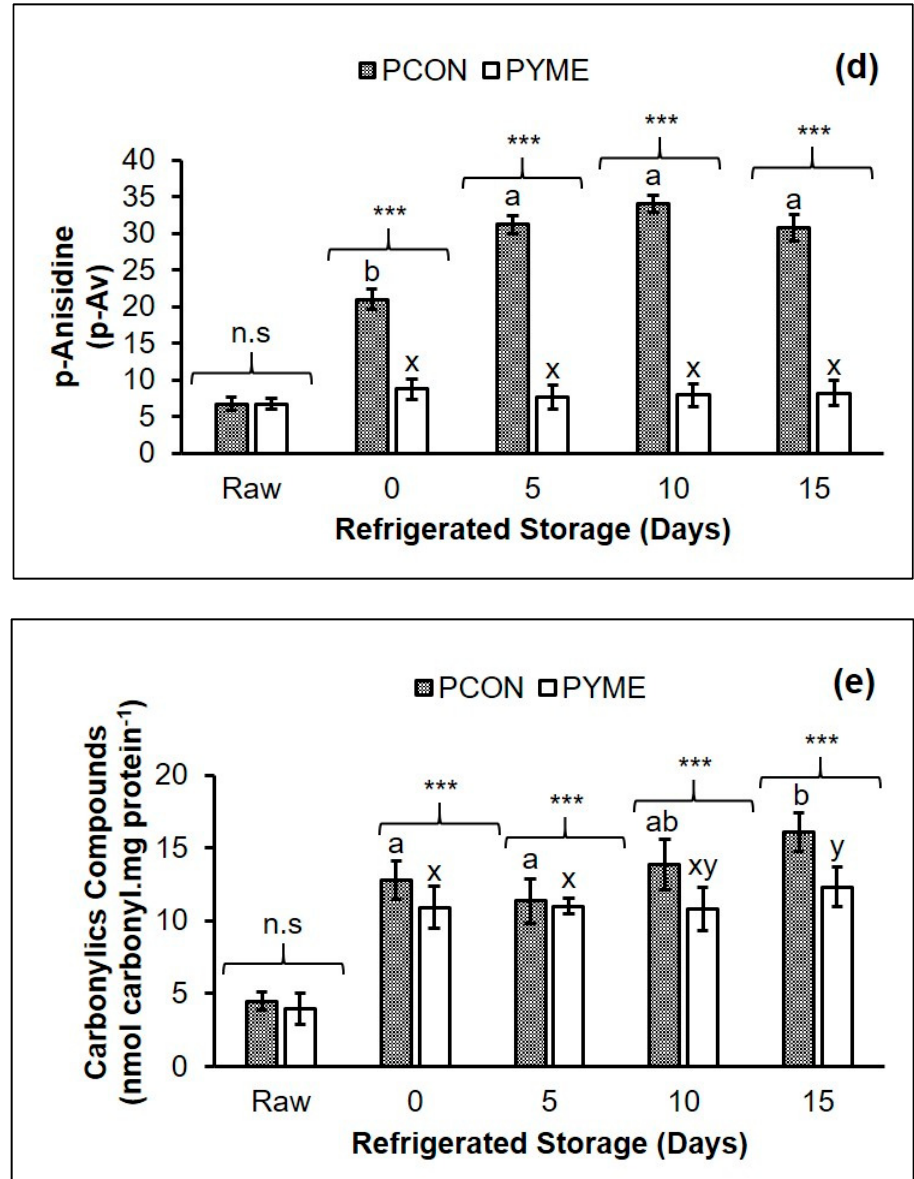
Figure 2. Effect of refrigerated storage (15 days at 4 ± 1 °C) on lipid and protein oxidation of chicken patty without (PCON) and with the addition of yellow mombin extract (PYME). Peroxide index ( a ), conjugated dienes ( b ), TBARS ( c ), p -anisidine ( p -Av) ( d ), and formation of carbonyl compounds ( e ). Results were expressed as mean ± standard deviation. Footnotes: Different letters in the upper part of the bars (a–d means within the PCON samples and x–z means within the PYME samples) differ significantly ( p < 0.05) between the days of refrigerated storage. The asterisks show significant differences between the samples on each day of refrigerated storage, n.s: non-significant, ***: p < 0.001. A reduced TBARS’ value was found in treated samples immediately after